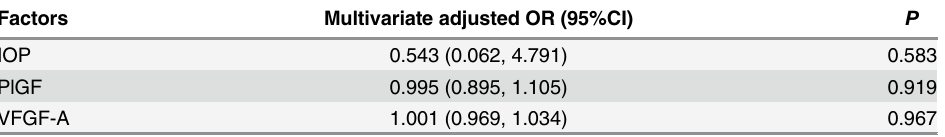
Table 2. Multivariate analysis of risk factors associated with NVG.